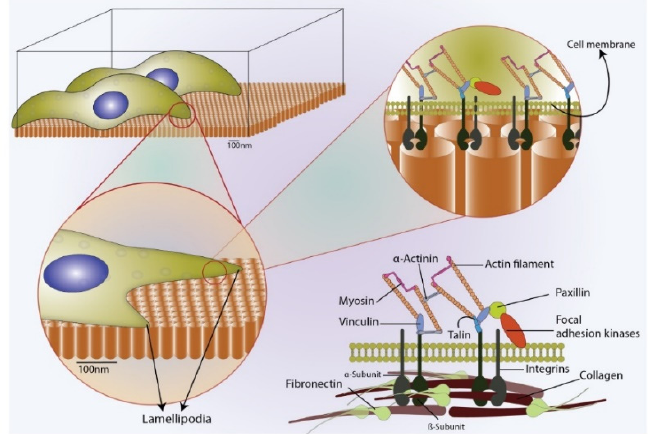
Figure 5. A schematic of cell-surface-induced mechanism, focal adhesion contact points for lamellipodia during cell adhesion on the nanotubular surface.